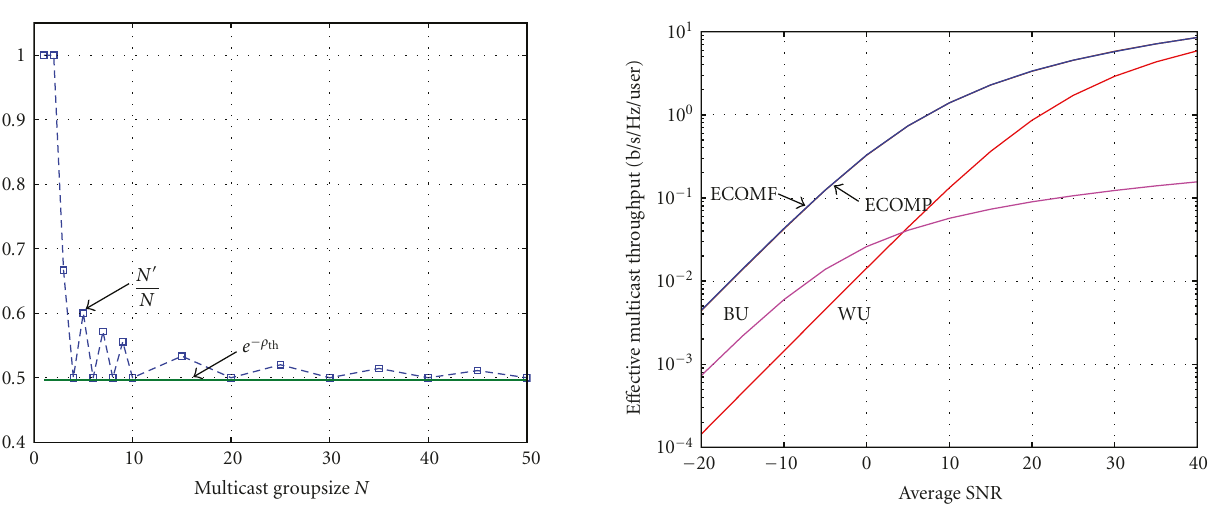
Figure 6: Throughputs given by di ff erent schemes versus average SNRs (Rayleigh fading channel, 100